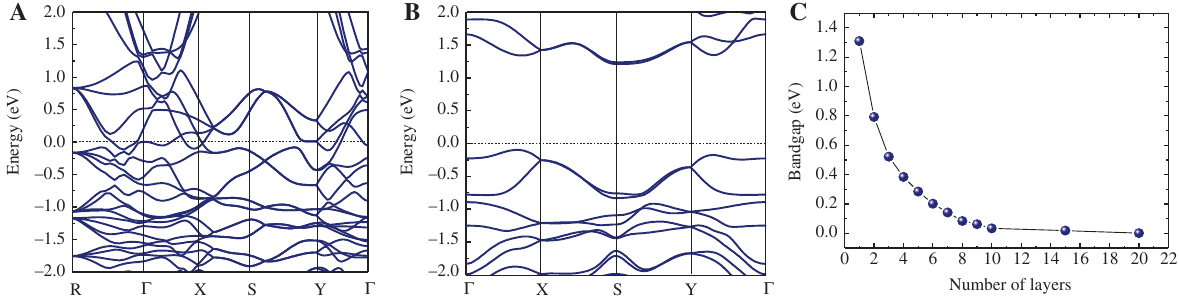
Figure 2: Calculated results of the electronic band structures and bandgap values. Electronic band structures of (A) bulk PdSe